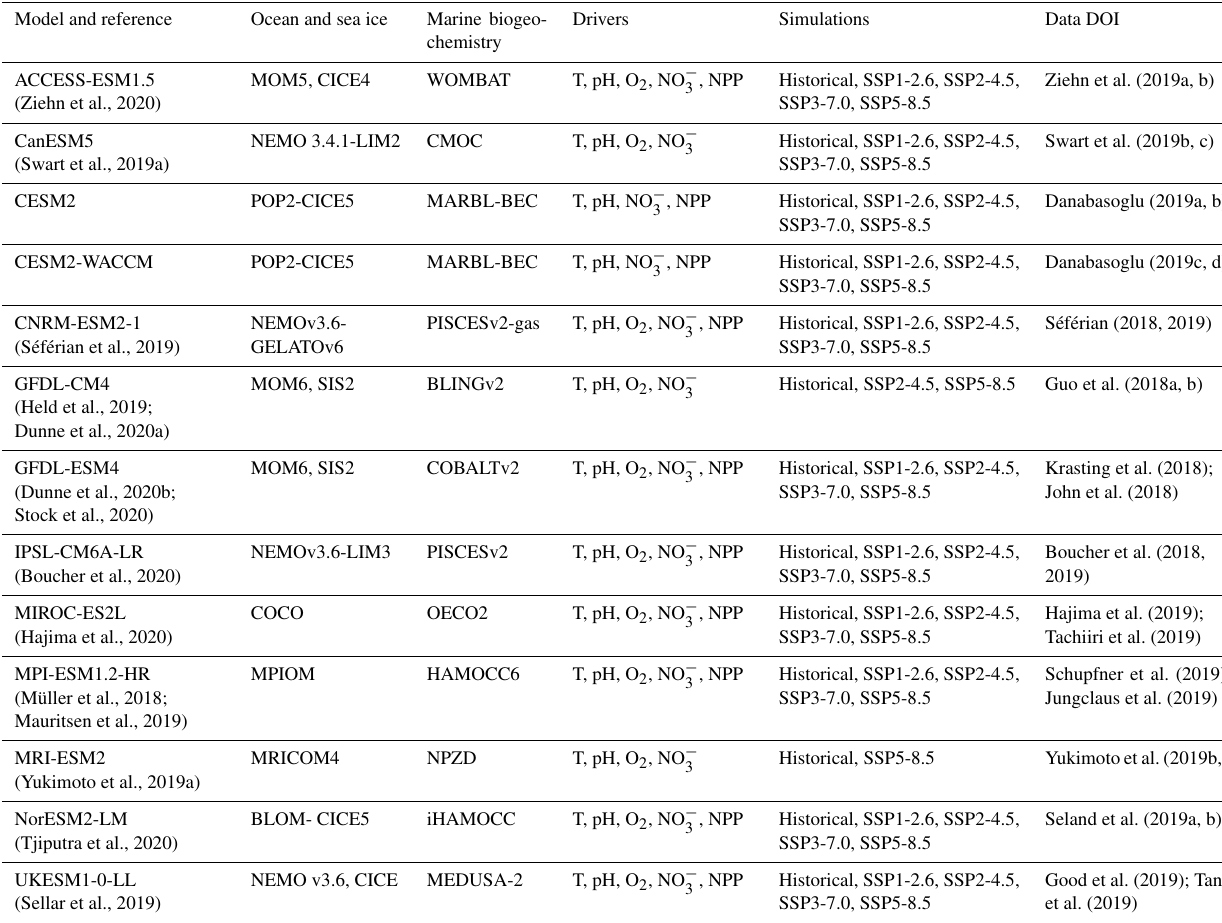
Table 1. The CMIP6 Earth system models used in this study; their individual components used to represent ocean, sea ice, and marine biogeochemistry; and the ocean impact drivers and simulations that were